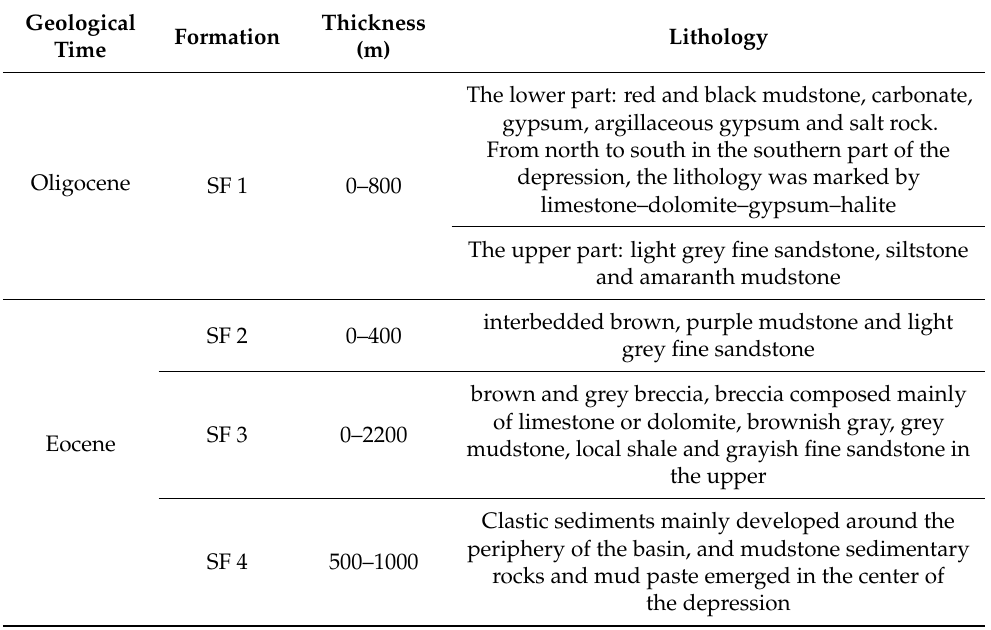
Table 1. Characteristics of the Shahejie Formation in Shulu depression, Bohai Bay Basin, North